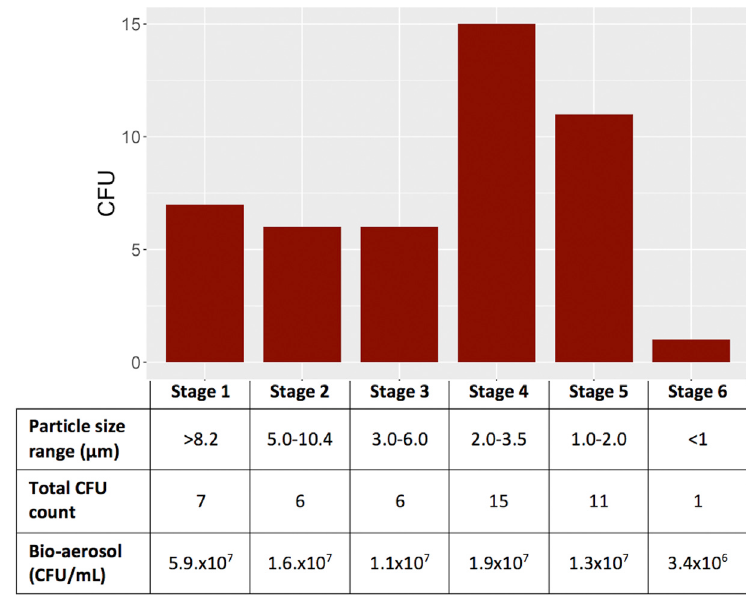
Figure 4. Histogram of total number of M. tuberculosis colony forming units in each of the 6 stages of Andersen impactors. The size range of collected particles and the calculated mean concentrations of CFUs per millilitre of captured bio-aerosol are shown in table.